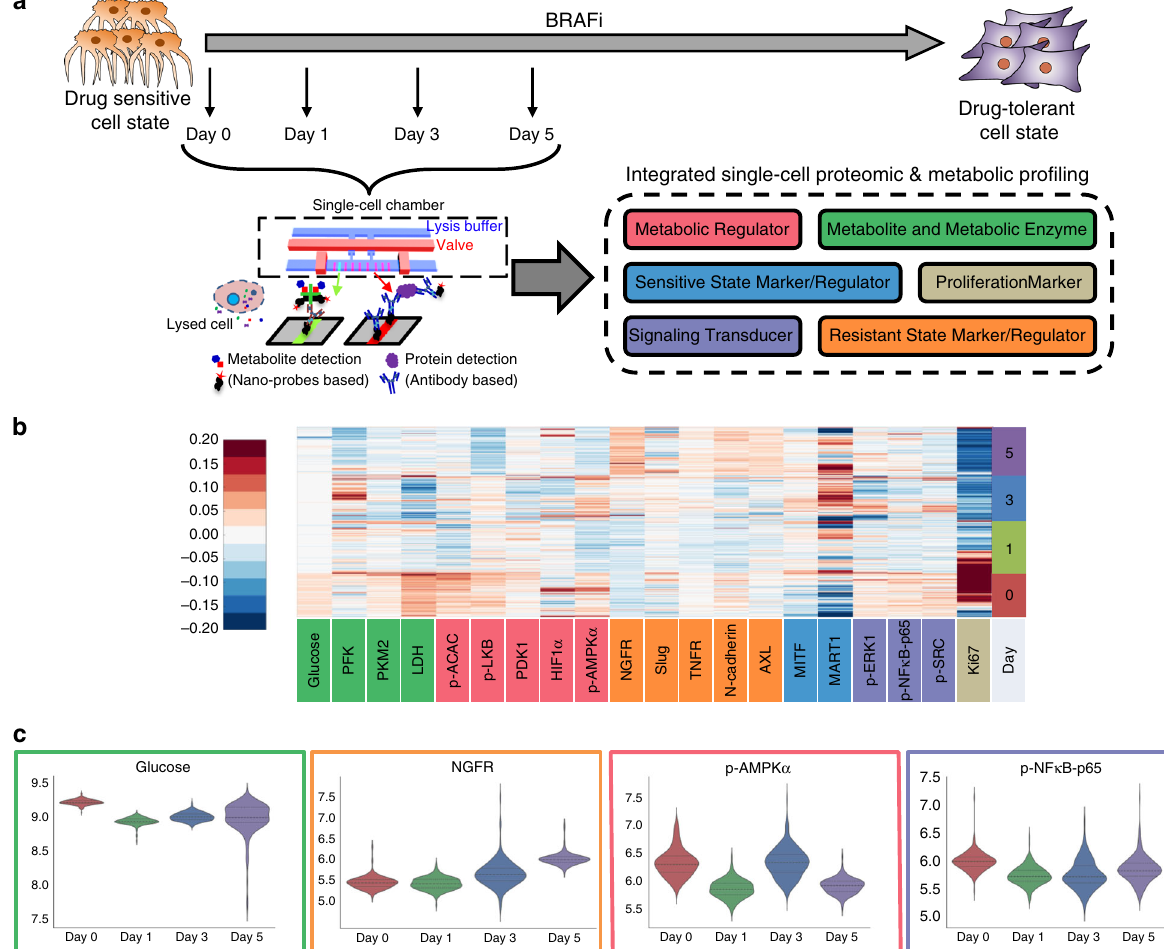
Fig. 1 Single-cell proteomic and metabolic analysis of early drug response in M397 cells. a The single-cell integrated proteomic and metabolic analysis experiments design. Cells from different time points during BRAFi treatment are collected and individually analyzed using the micro fl uidic-based single-cell barcode (SCBC) technology. Each cell was characterized for the levels of six different categories of markers. b Heatmap representation of integrated proteomic and metabolic analysis dataset. Each row represents an individual cell and each column (except the last column) represents an individual analyte, with the color in the heatmap representing the measured level of the analyte. The last column represents the number of days after starting BRAFi treatment. On the X-axis, markers are colored corresponding to which of the six functional categories they belong to. c Violin plot representation of the distribution of certain representative markers across four time points. Y-axis represents the natural log of the measured marker level. Each plot is bordered by the color of the functional category of the measured